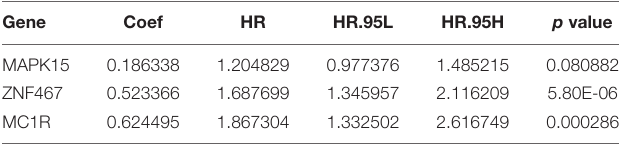
TABLE 3 | Risk genes in the prognostic risk